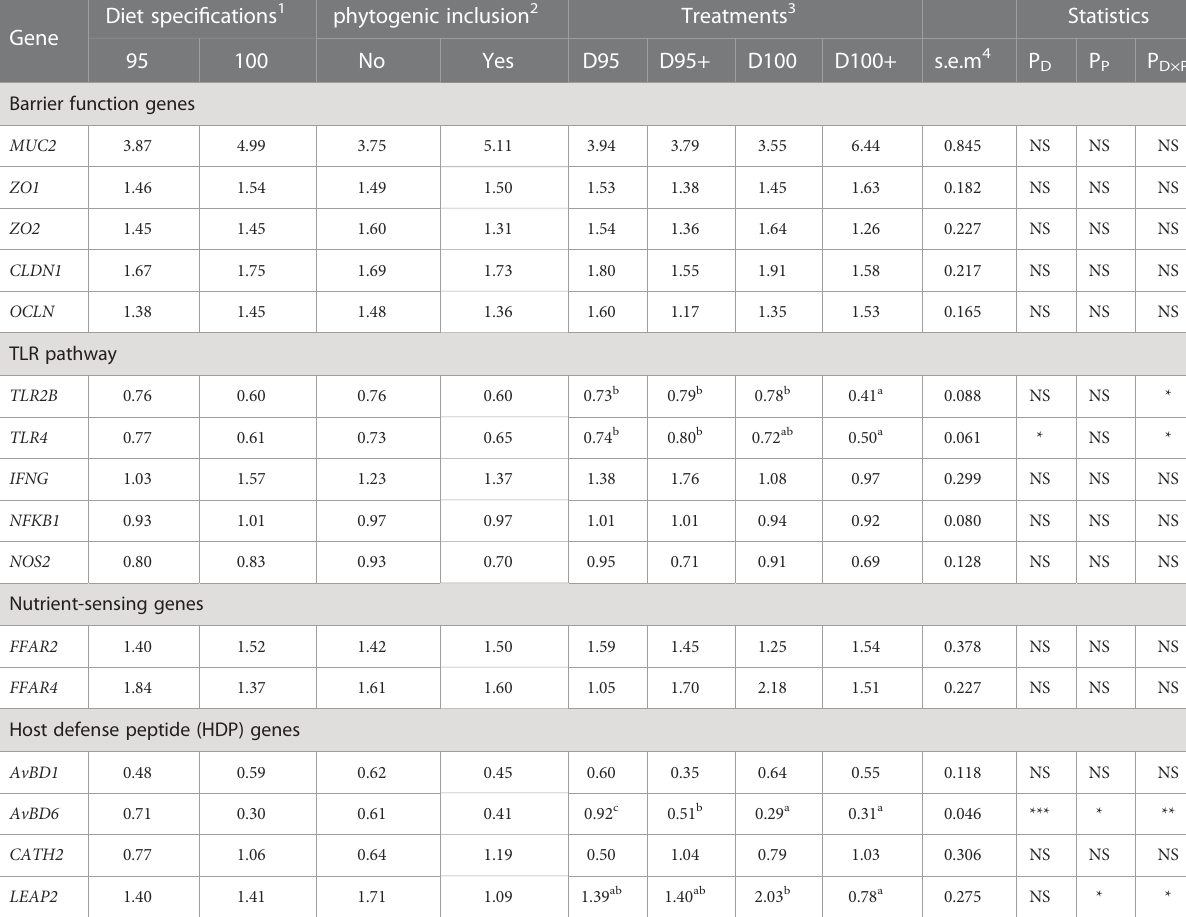
TABLE 5 Effects of diet speci fi cations %, phytogenic inclusion, and their interaction on mRNA expression of, barrier function, immune and nutrient sensing genes in chicken cecal mucosa.